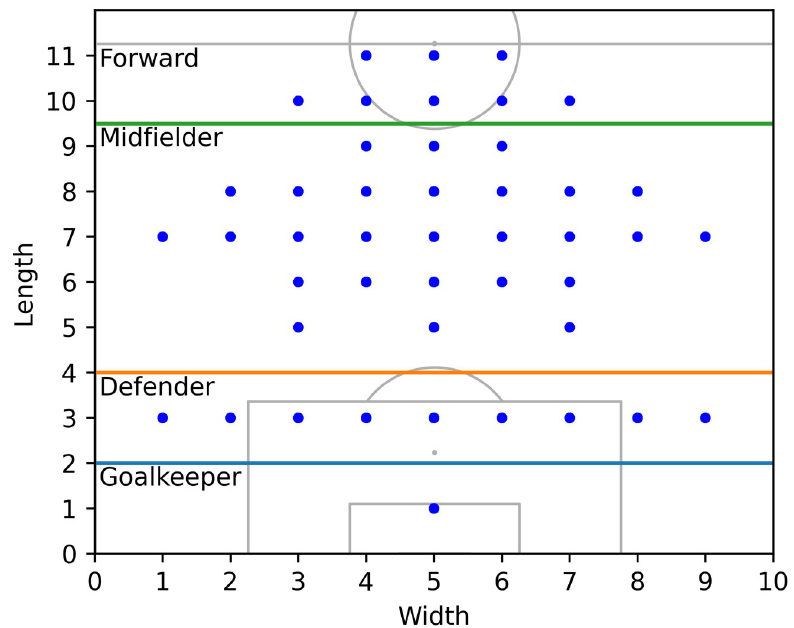
Fig 2. Role assignment based on player coordinates